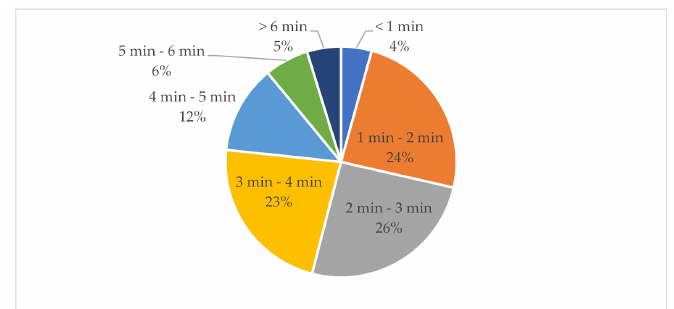
Figure 1. Duration of videos.